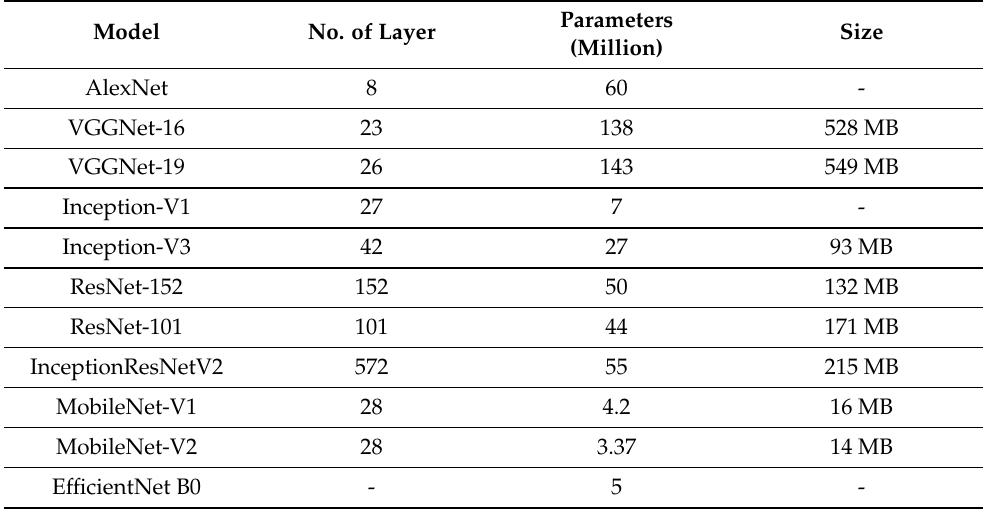
Table 2. Comparison among different CNN architectures regarding layer number and parameter size. Model